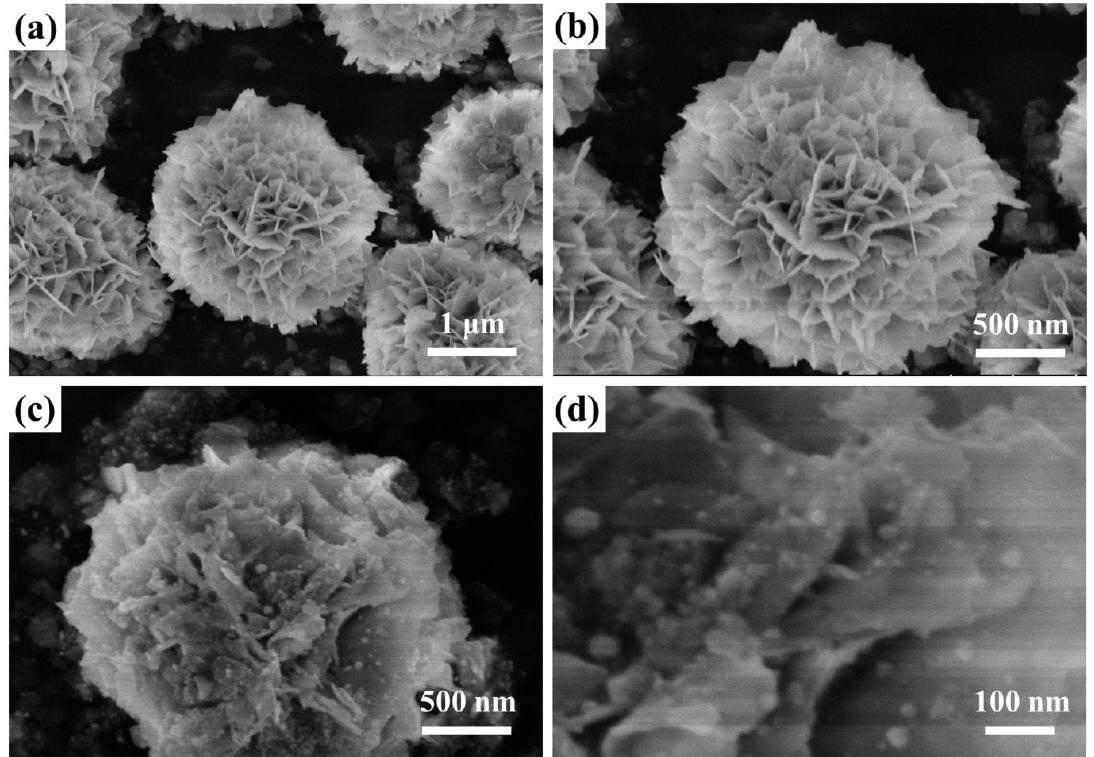
Figure 2. SEM images of ( a , b ) BiOCOOH and ( c , d ) Ag / AgCl / BiOCH-3.